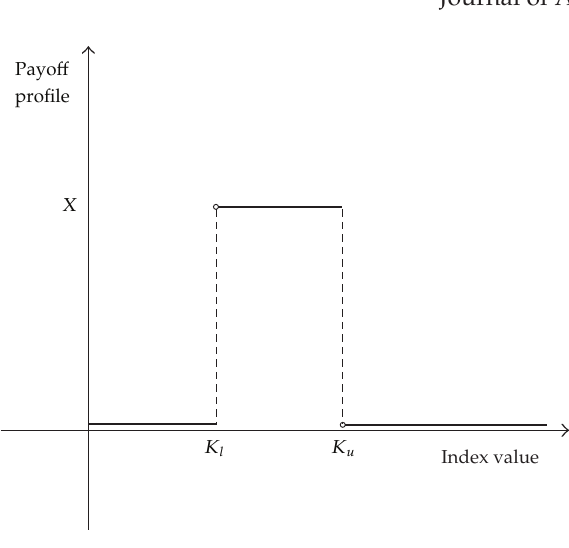
Figure 4: Structured products: portfolio